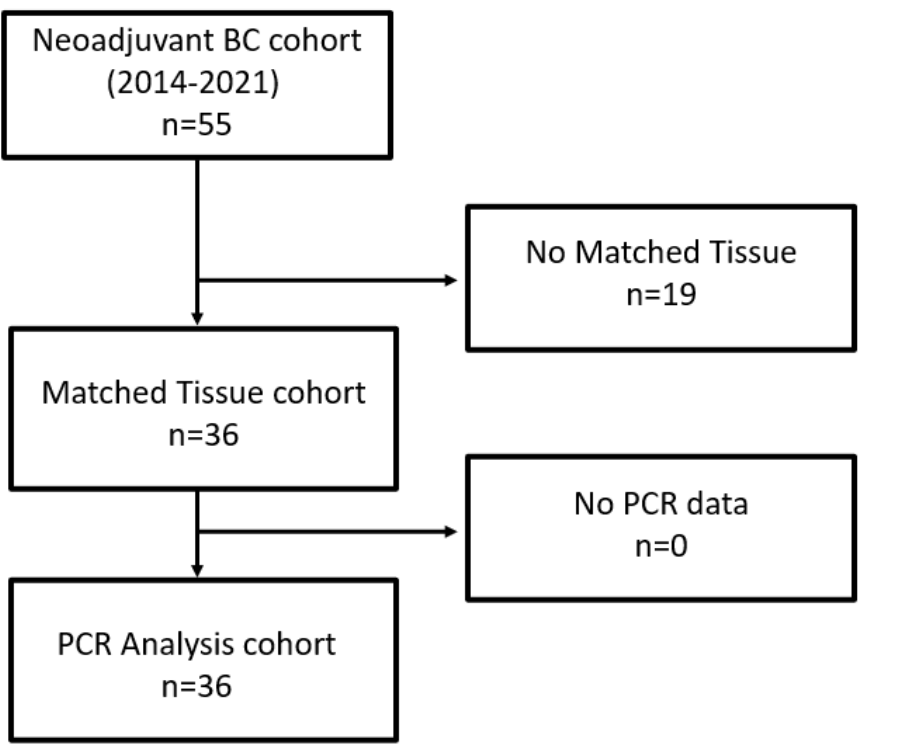
Figure 1. Remark Figure 1. Remark diagram.